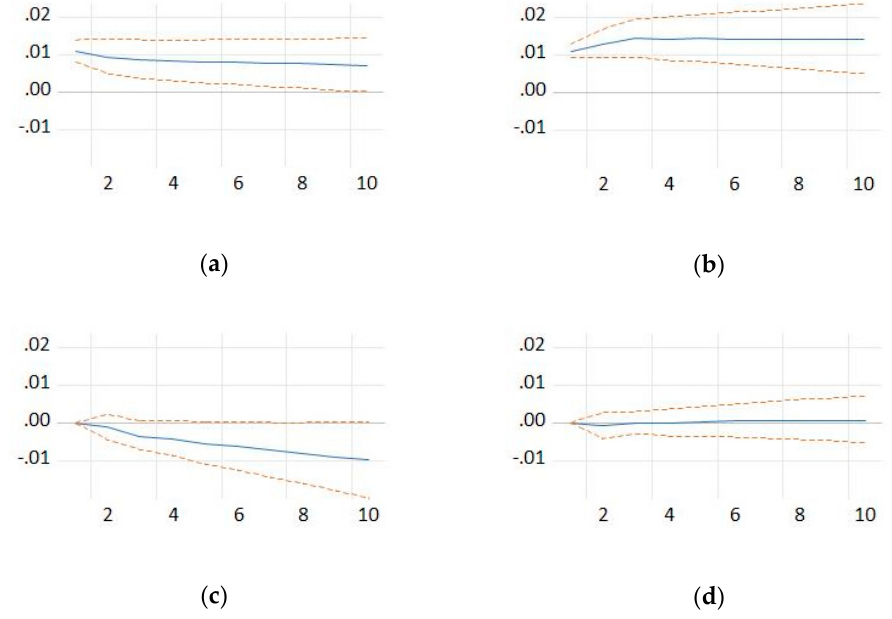
Figure 3. Response of nominal labor productivity per person to a shock from: ( a ) GDP per capita; ( b ) nominal labor productivity per person; ( c ) persons employed in the population of deaths; and ( d ) persons employed in the population of active enterprises. Source: the authors’ own computations.